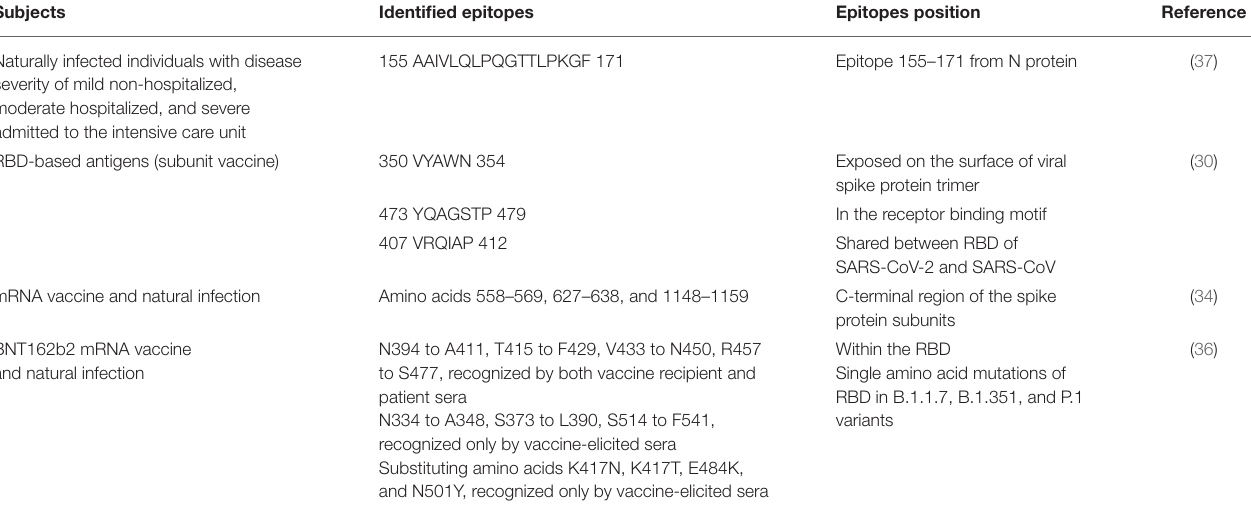
TABLE 1 | Comparison between the identified epitopes in mRNA and subunit COVID-19 vaccines and those in natural